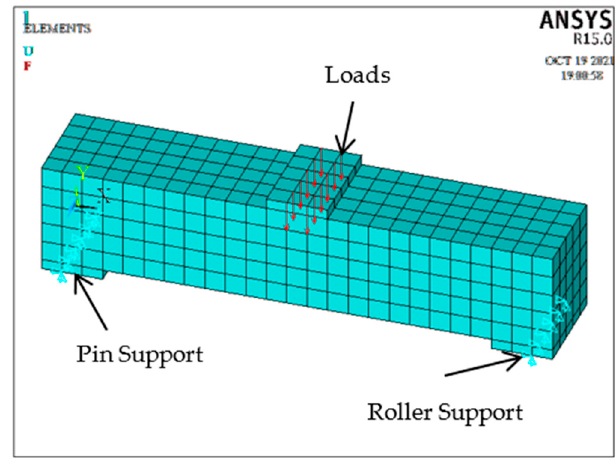
Figure 7. Supports and applied loads for a typical beam model.